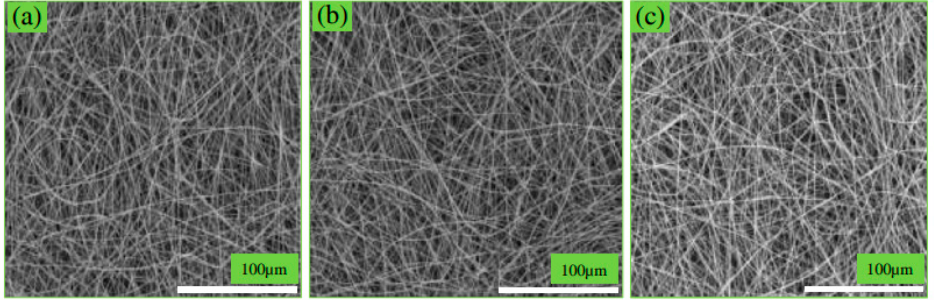
Figure 17. FE-SEM images of ( a ) pristine PLGA, ( b ) PLGA/nHA, and ( c ) PLGA/nHA-I nanofiber scaffolds [70].